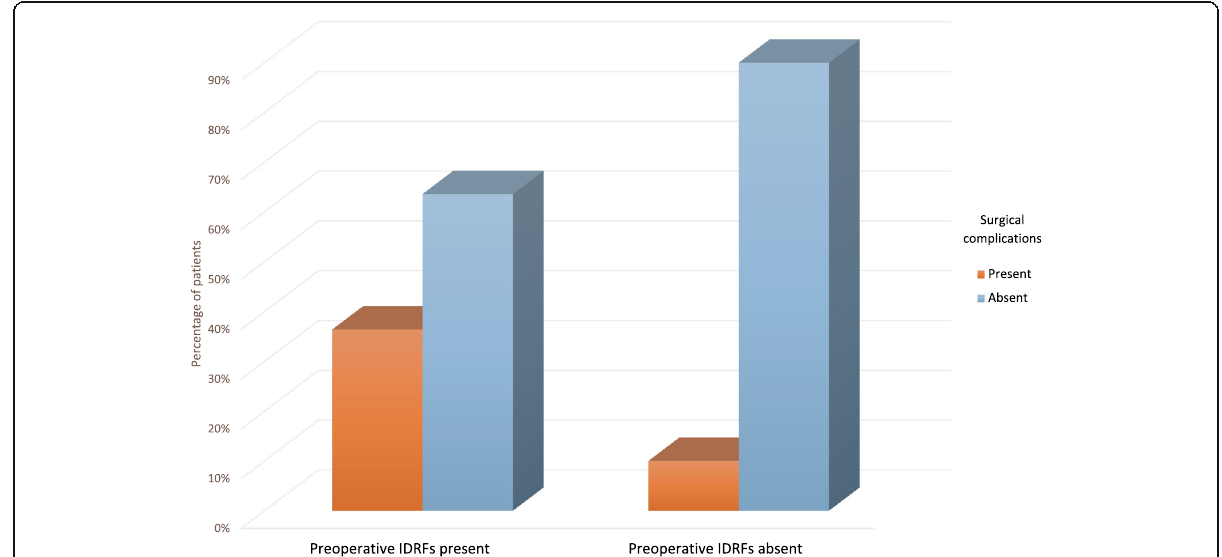
Fig. 11 Correlation between the pre-operative IDRFs and the surgical